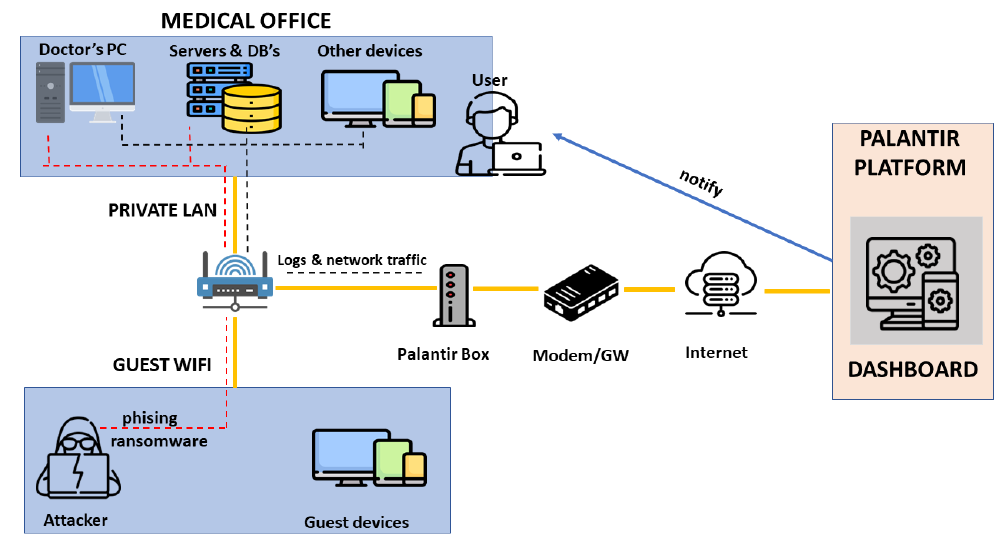
Figure 6. The testbed architecture of use case